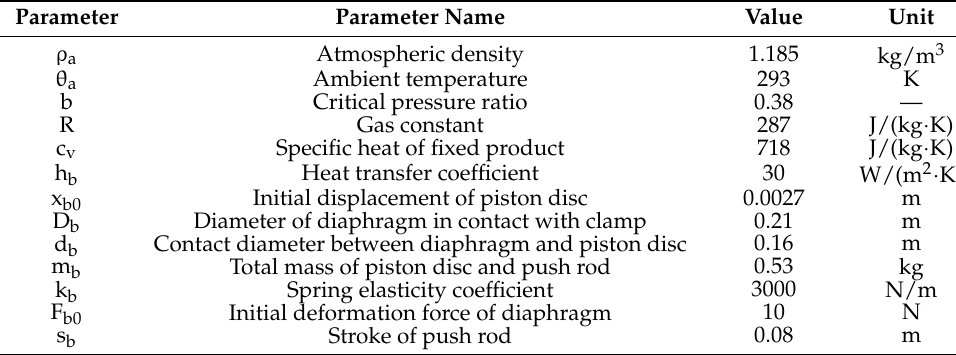
Table 1. Simulation parameters of brake chamber.